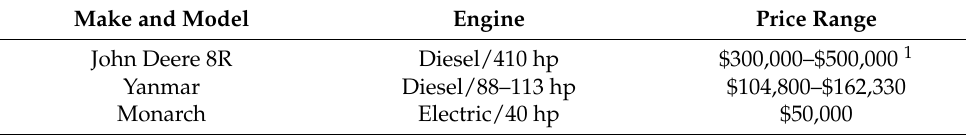
Table 3. Autonomous (self-driving) tractors, available on the market in 2022 [57,58]. Make and Model